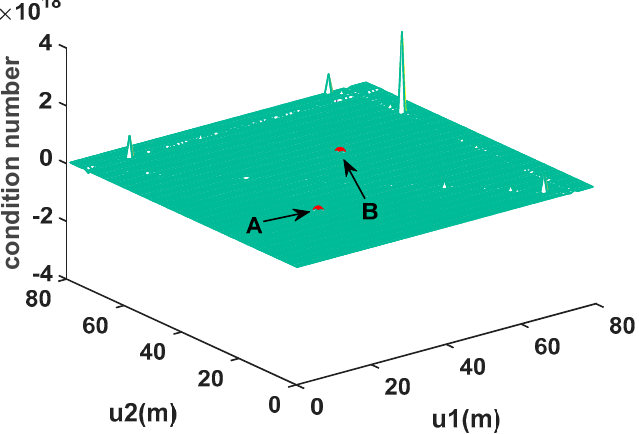
Figure 2. Surface Plot of condition number varying with u 1 and u 2 when x j 2 = 0.